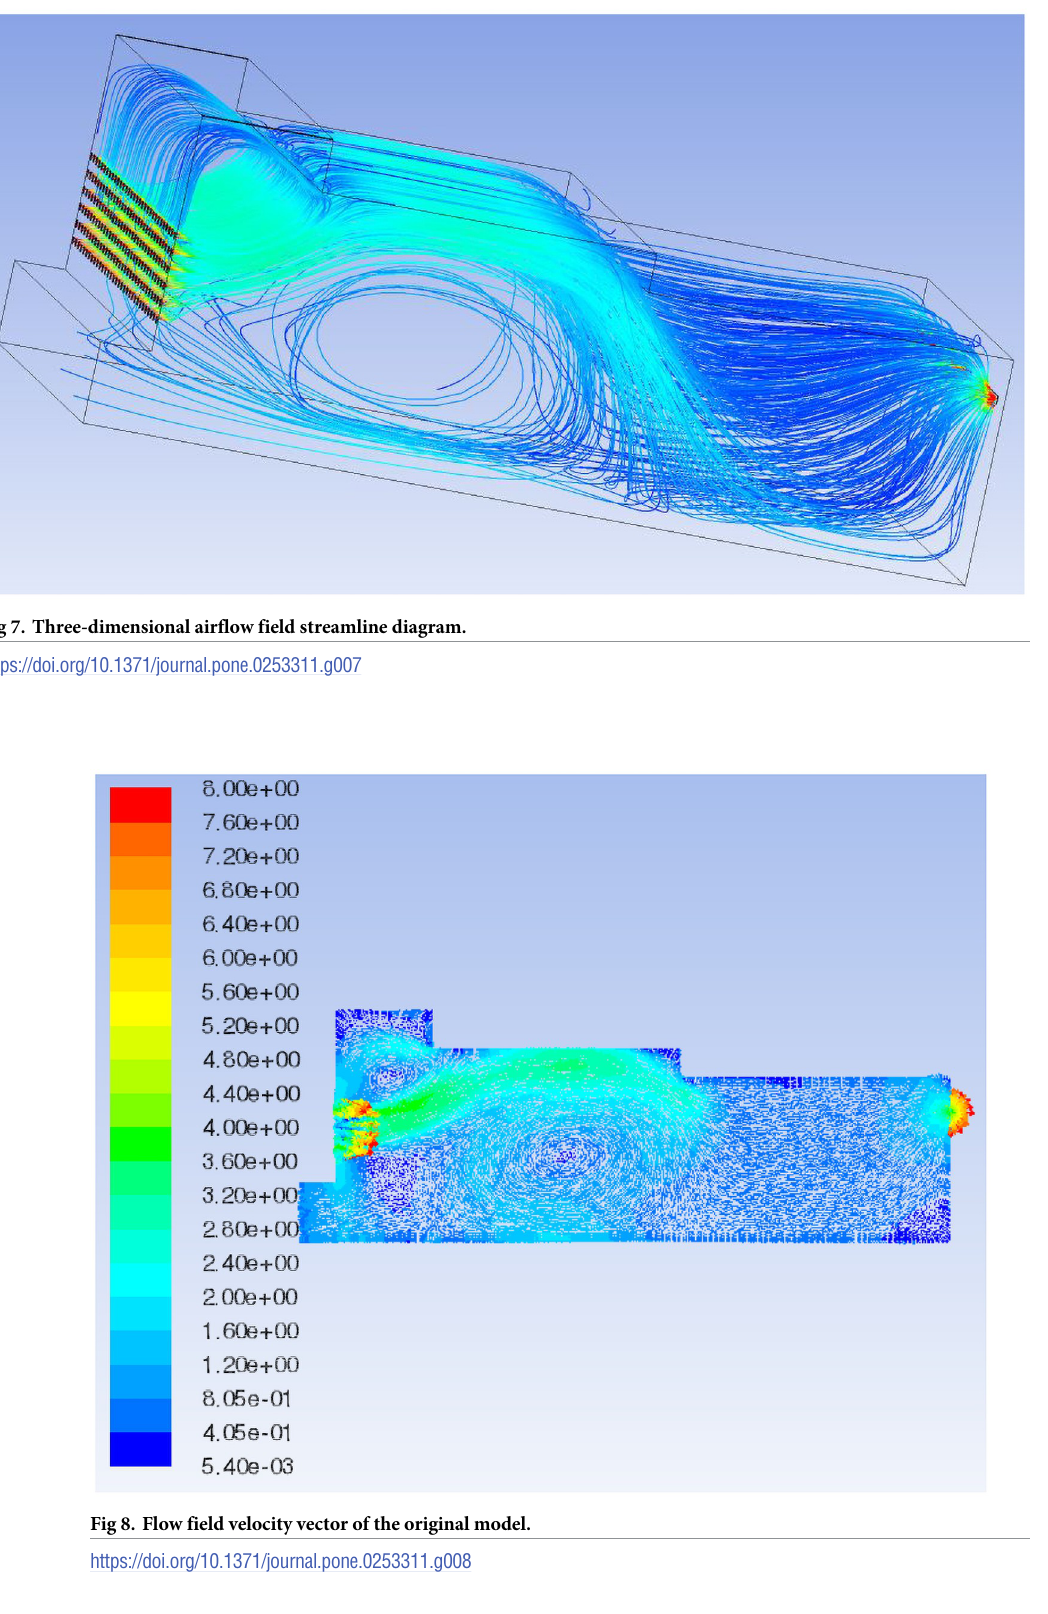
PLOS ONE | https://doi.org/10.1371/journal.pone.0253311 June 17,